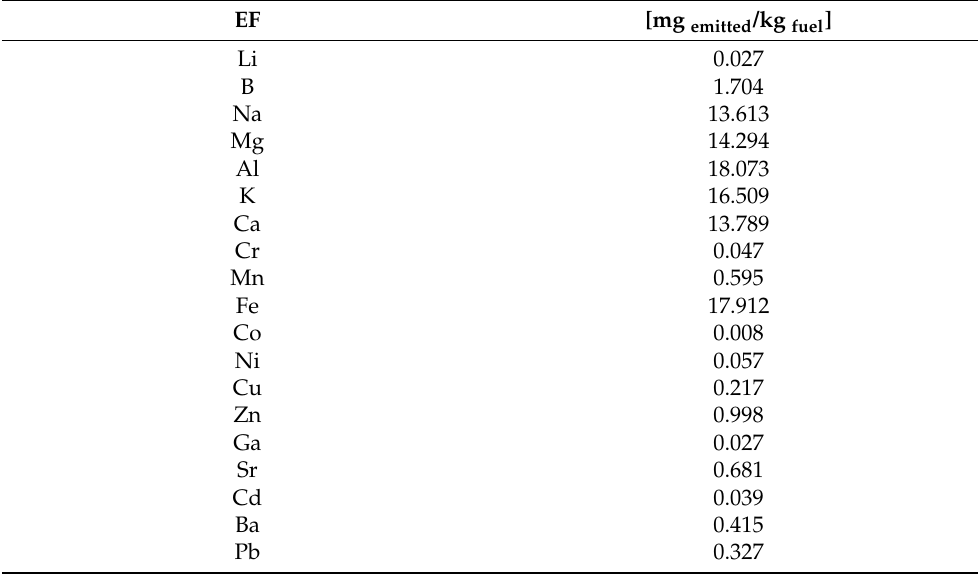
Table 11. Emission factors.